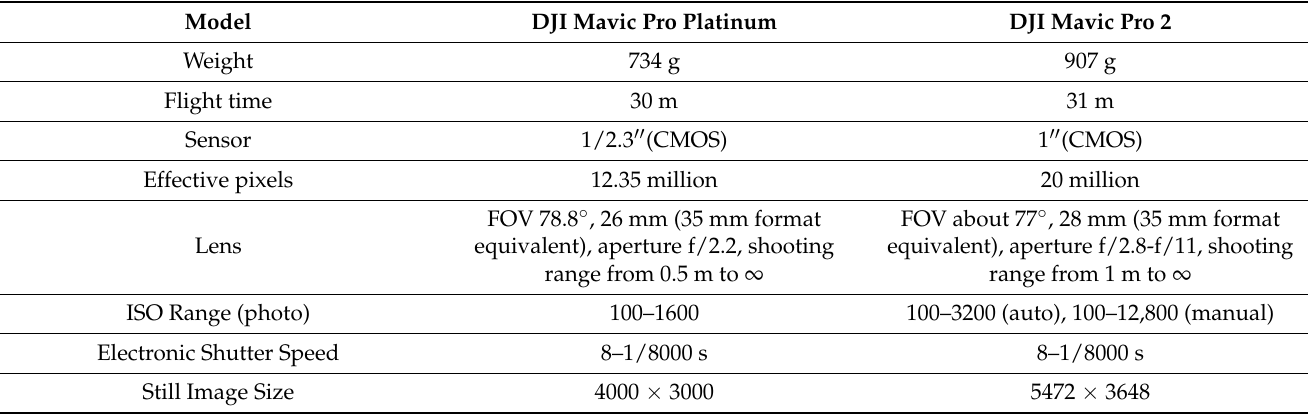
Table 1. Details on the two UAS vehicles used to capture cavity tree images. In spring 2022, training sample photos were captured at SHNF and CBC in Walker County and Montgomery County,